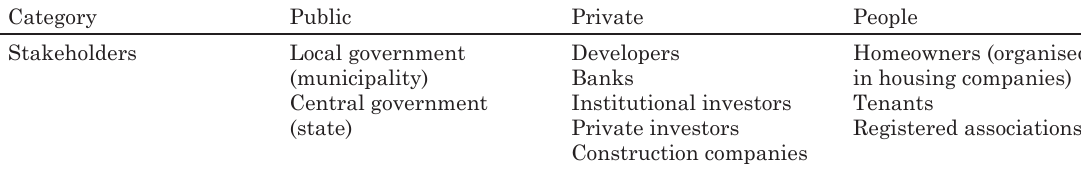
table 1. Categories and stakeholders in 4P urban development